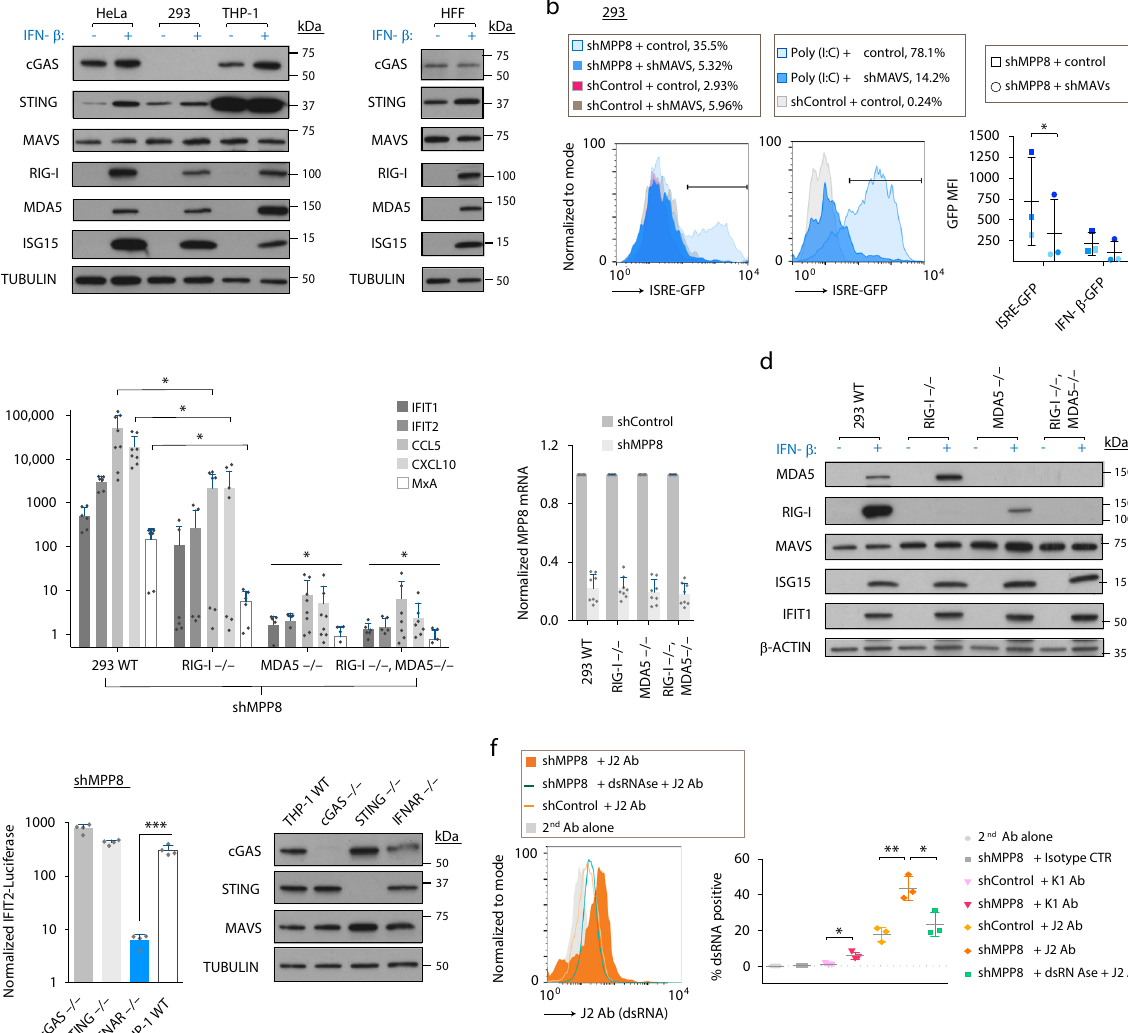
a dsRNA analog (Fig. 3b). To dissect whether MAVS signaling was mainly dependent on RIG-I or MDA5, we employed CRISPR/Cas9-generated knockout 293 cells for either or both dsRNA sensors. Results showed that the response is dependent on